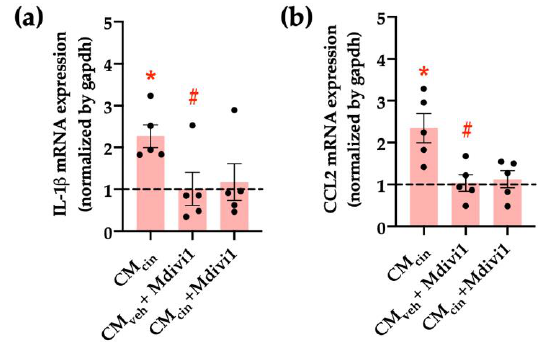
Figure 11. Inhibition of mitochondrial fission prevents the increase in pro-inflammatory cytokines induced by CMcin in HepG2 cells: relative abundance of ( a ) IL- 1β and ( b ) CCL2 mRNA in HepG2 cells exposed to CM cin , CM veh + Mdivi1, and CM cin + Mdivi1, expressed as fold from CM veh , represented by the dotted line. mRNA levels were normalized to GAPDH mRNA. Each dot represents an individual experiment ( n = 5). * p < 0.01 versus the control, # p < 0.05 versus CM cin , and the Wilcoxon signed rank test.